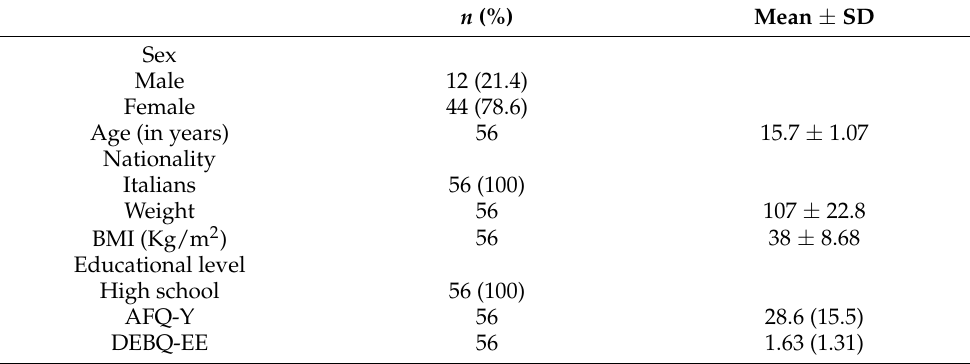
Table 1. Descriptive statistics of the